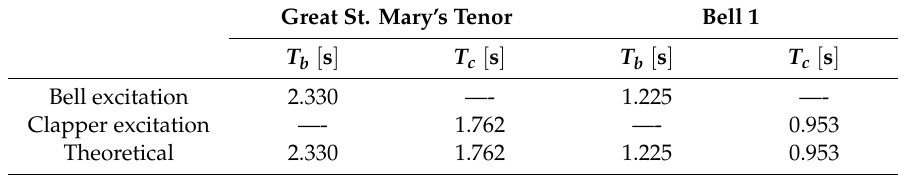
Figure 6. Small free oscillations of the bell 1: ( a ) Oscillation of bell in case of bell excitation; ( b ) Oscillation of bell and clapper in case of clapper excitation. Table 2. Comparison between theoretical and numerical results—periods of free